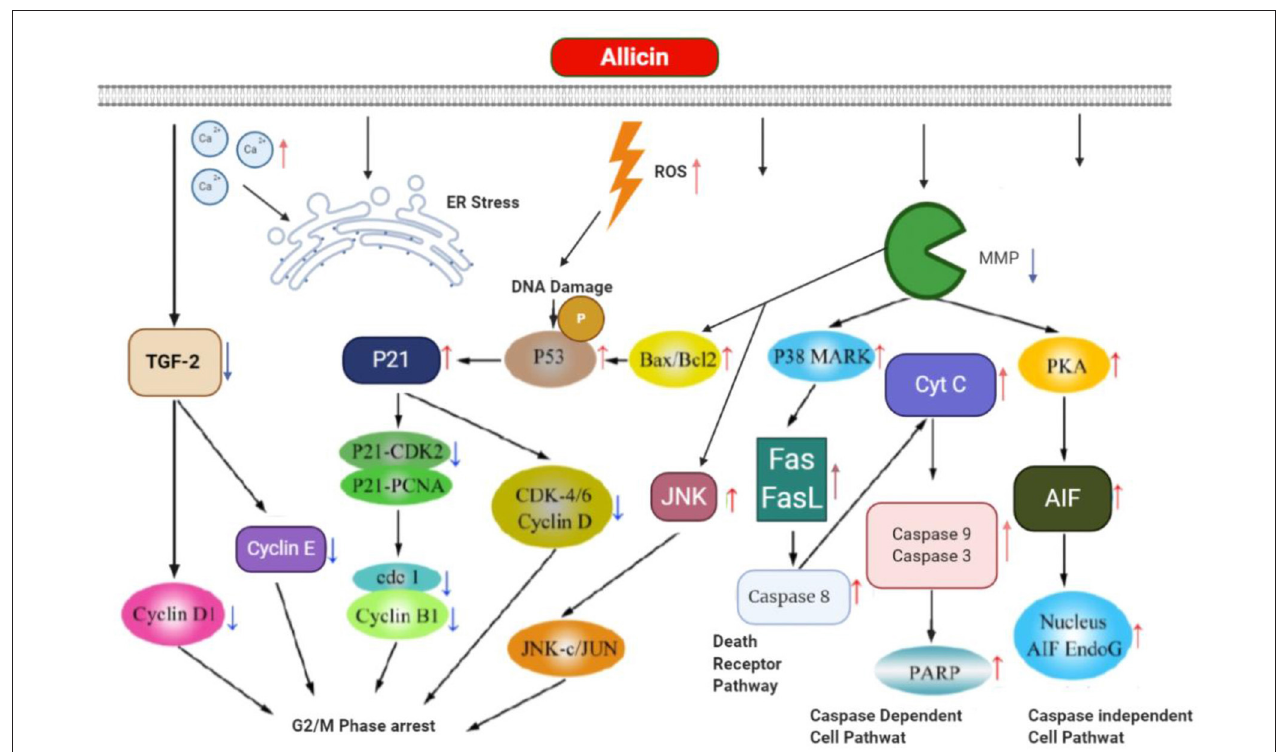
FIGURE 5 | The apoptosis and its related mechanism mediated by allicin in gastric cancer